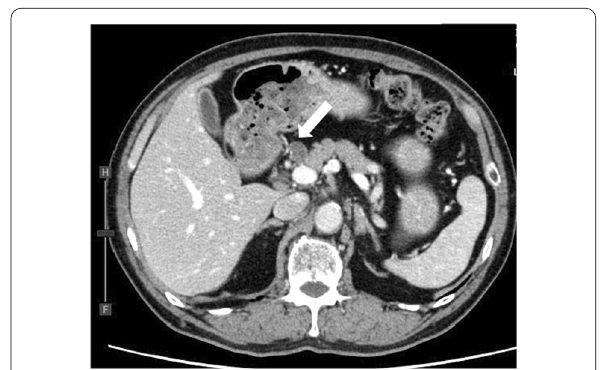
Fig. 1 Radioiodine whole-body scintigraphy demonstrated uptake of I-131 in the thyroid bed and the pancreas head (white arrow)